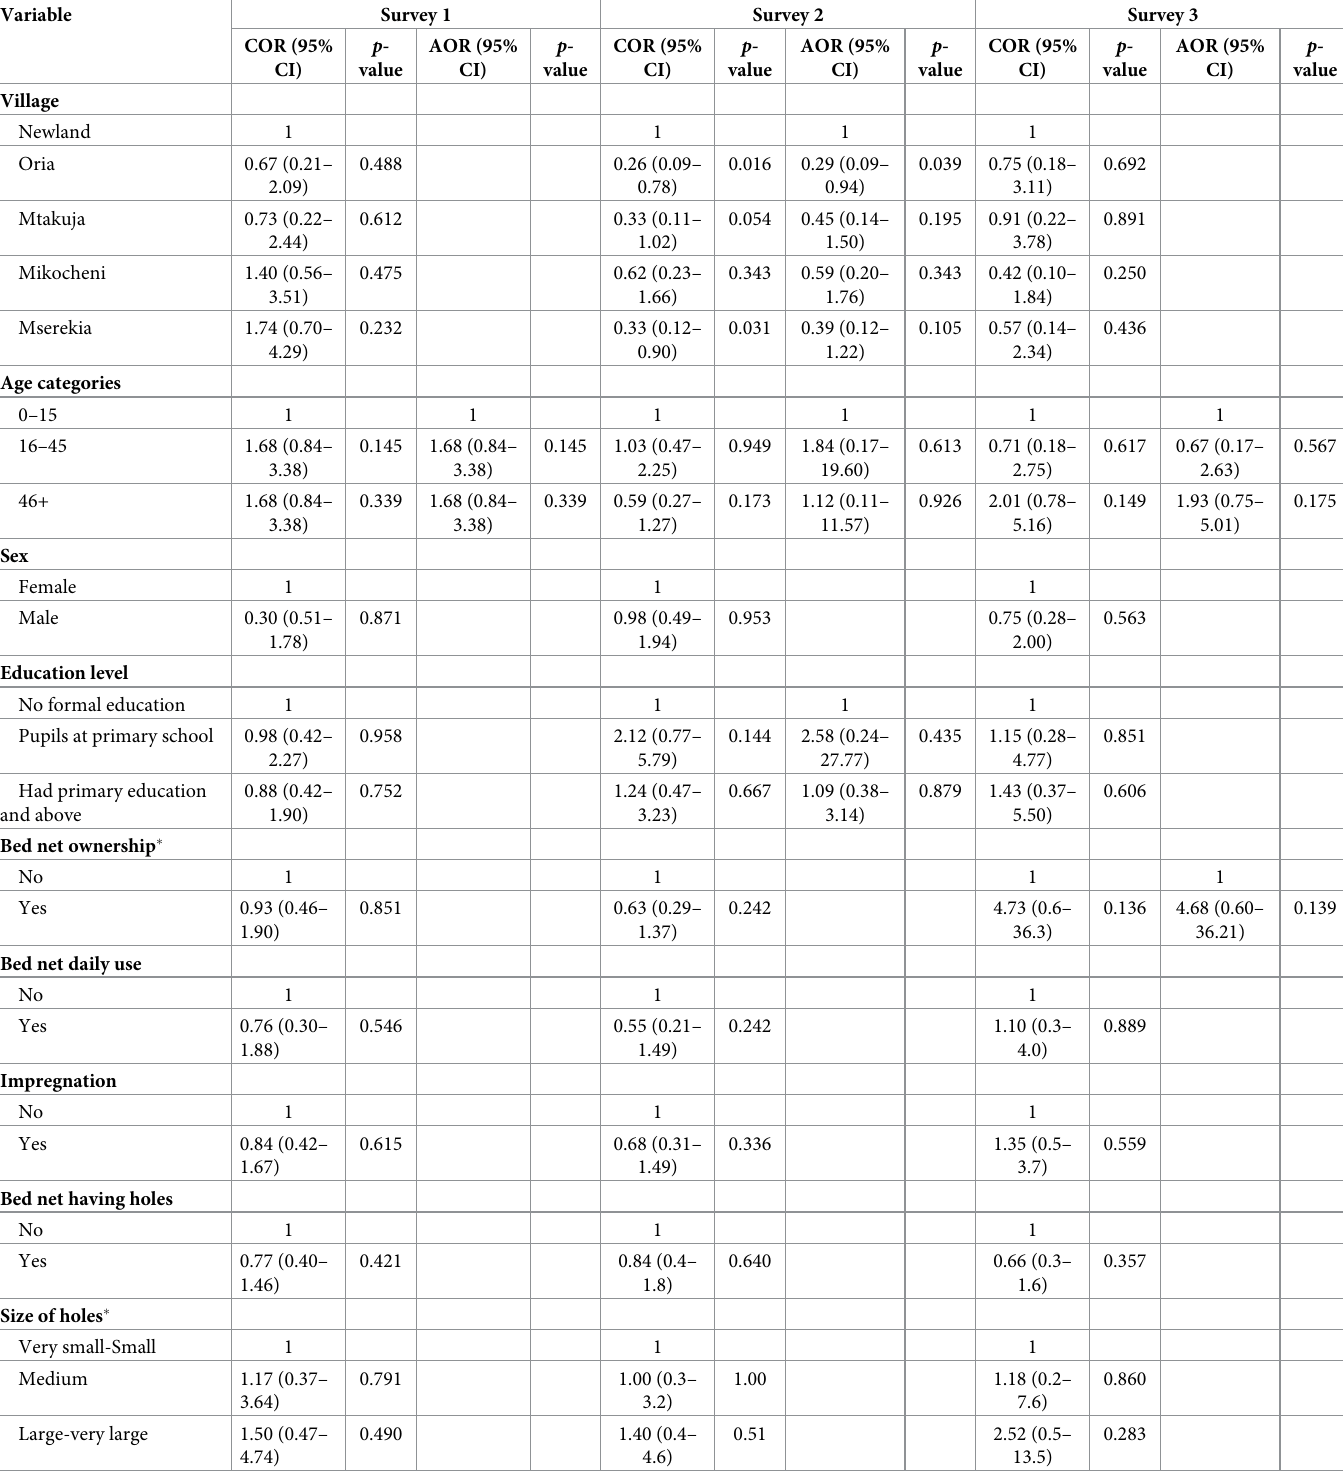
Table 4. Univariate and multivariate analysis of factors associated with risk of exposure to Anopheles bites in Lower